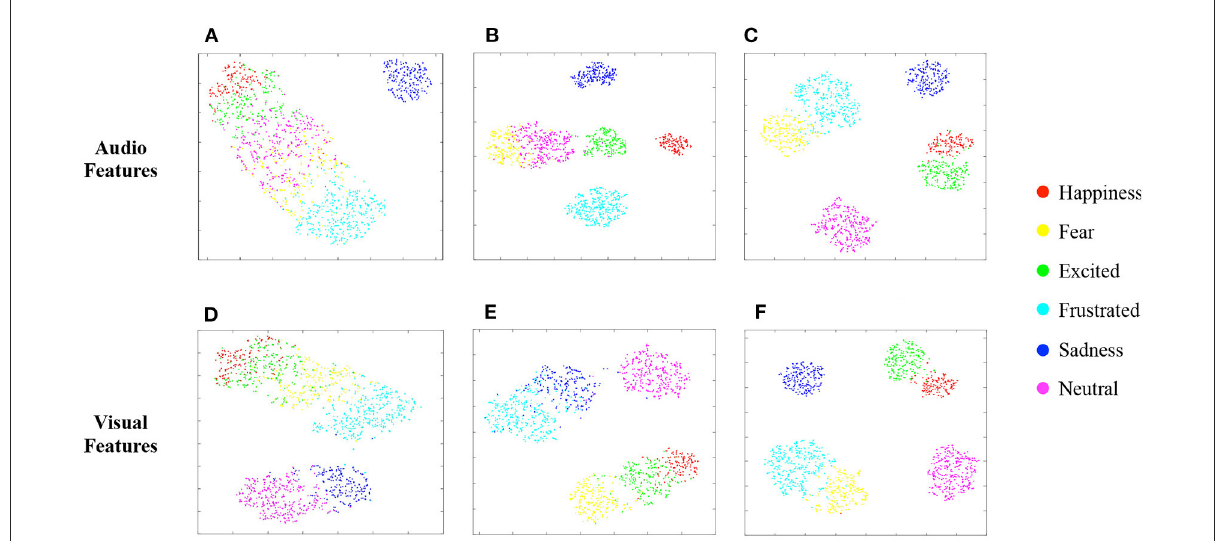
FIGURE6 Visualization of audio and visual feature distribution on IEMOCAP. (A) SER w/o SEM, w/o MBT. (B) SER w/SEM, w/o MBT. (C) MER w/SEM, w/MBT. (D) FER w/o SEM, w/o MBT. (E) FER w/SEM, w/o MBT. (F) MER w/SEM, w/o MBT.